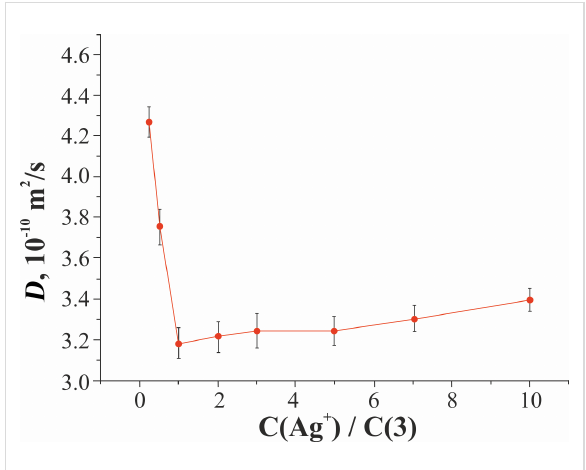
Figure 4: Change in the diffusion coefficients of macrocycle 3 and 3 /Ag + associates.